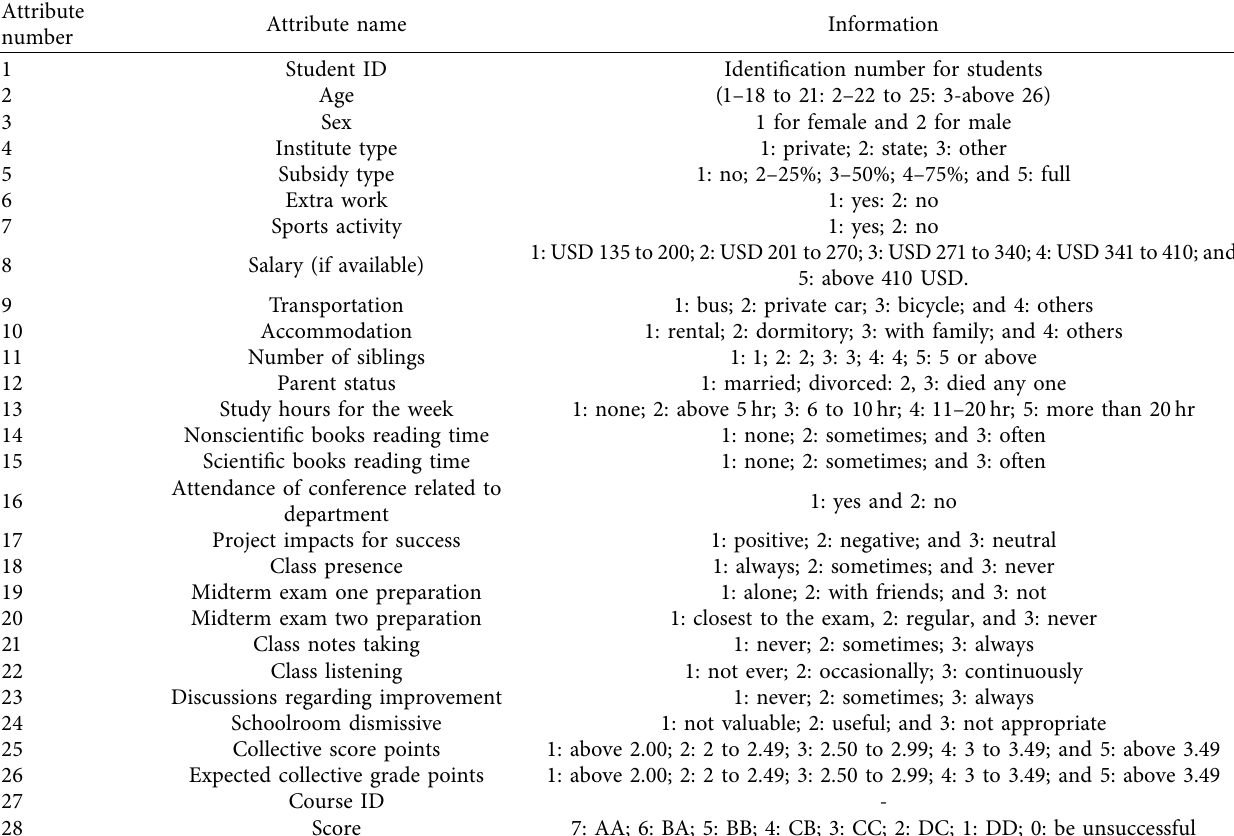
Table 1: Dataset attribute